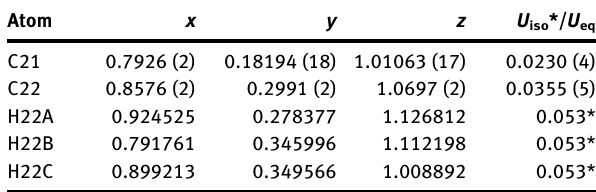
Table  : Fractional atomic coordinates and isotropic or equivalent isotropic displacement parameters (Å 